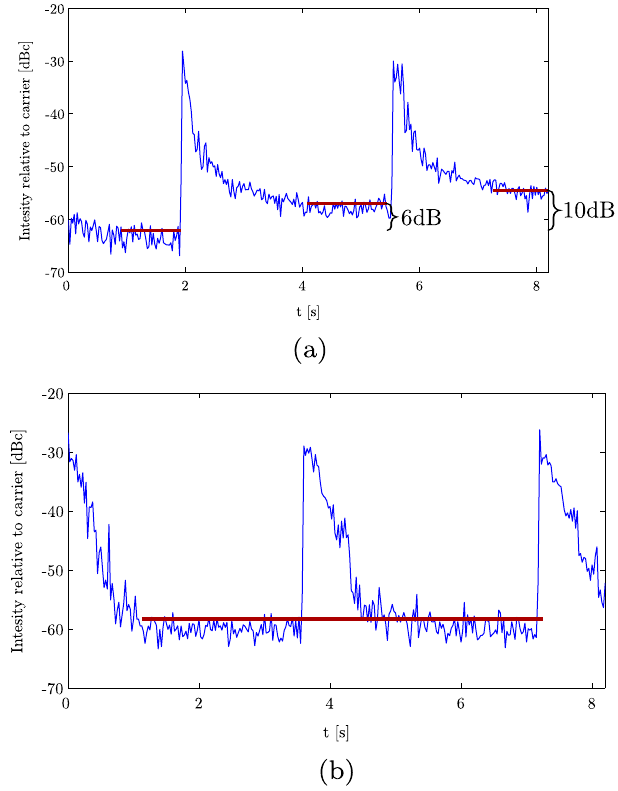
FIG. 5. Phase modulation signal over time in the uncoated (a) and coated (b) section. The peaks in the graph correspond to the injection of a new batch. The data were taken with the nominal LHC 25 ns beam of four batches at SPS flat